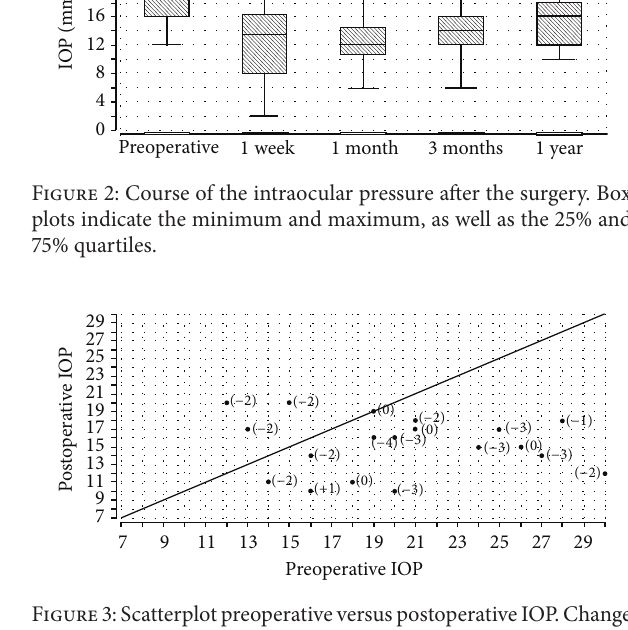
Figure3:ScatterplotpreoperativeversuspostoperativeIOP.Change in number of medication in